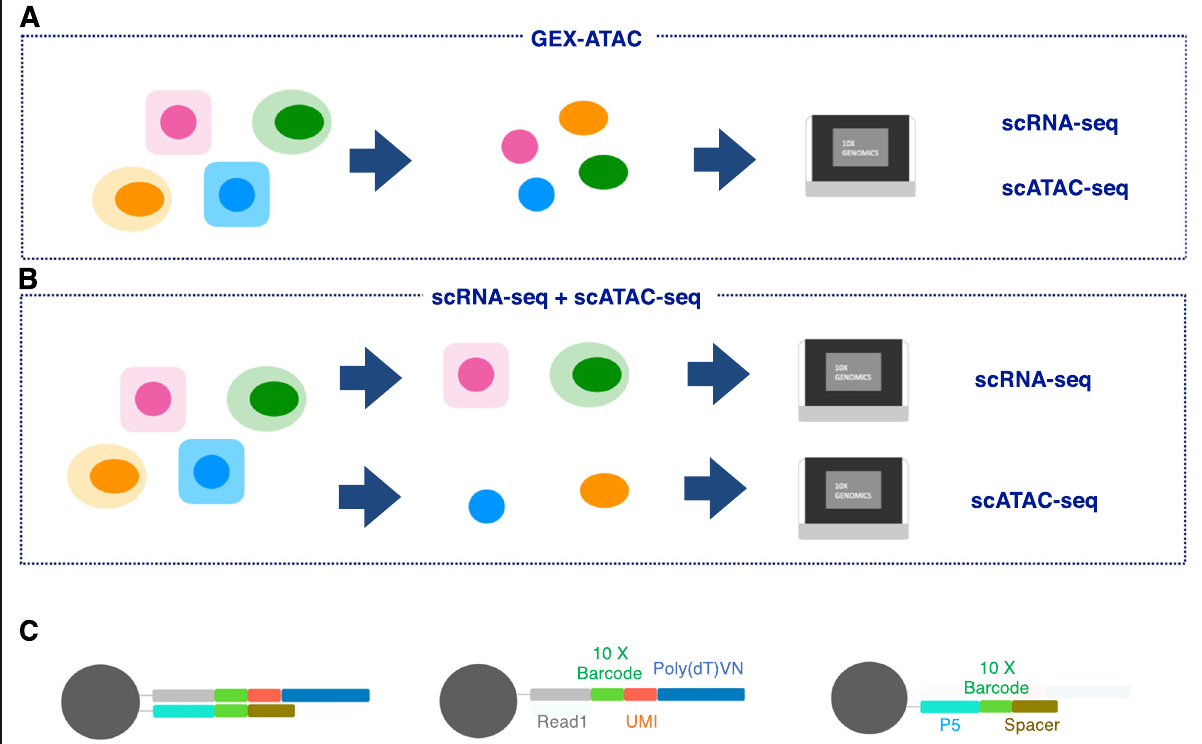
Fig. 3 Overview of previous and current single-cell multiome analysis. In the previous version of the 10x chromium system, we could not use identical cells in both scRNA-seq and scATAC-seq ( a ). We acquired the dataset from an identical cell using the new system ( b ). Due to changes in sample preparation before barcoding, nuclear RNA, not cellular RNA, was analyzed in the new system. c Each gel bead has two types of primers to identify each cell (left): primers for scRNA-seq (middle) and primers for scATAC-seq (right) ( c ). Using 10x barcodes, we could distinguish cells in both the scATAC-seq dataset and the scRNA-seq